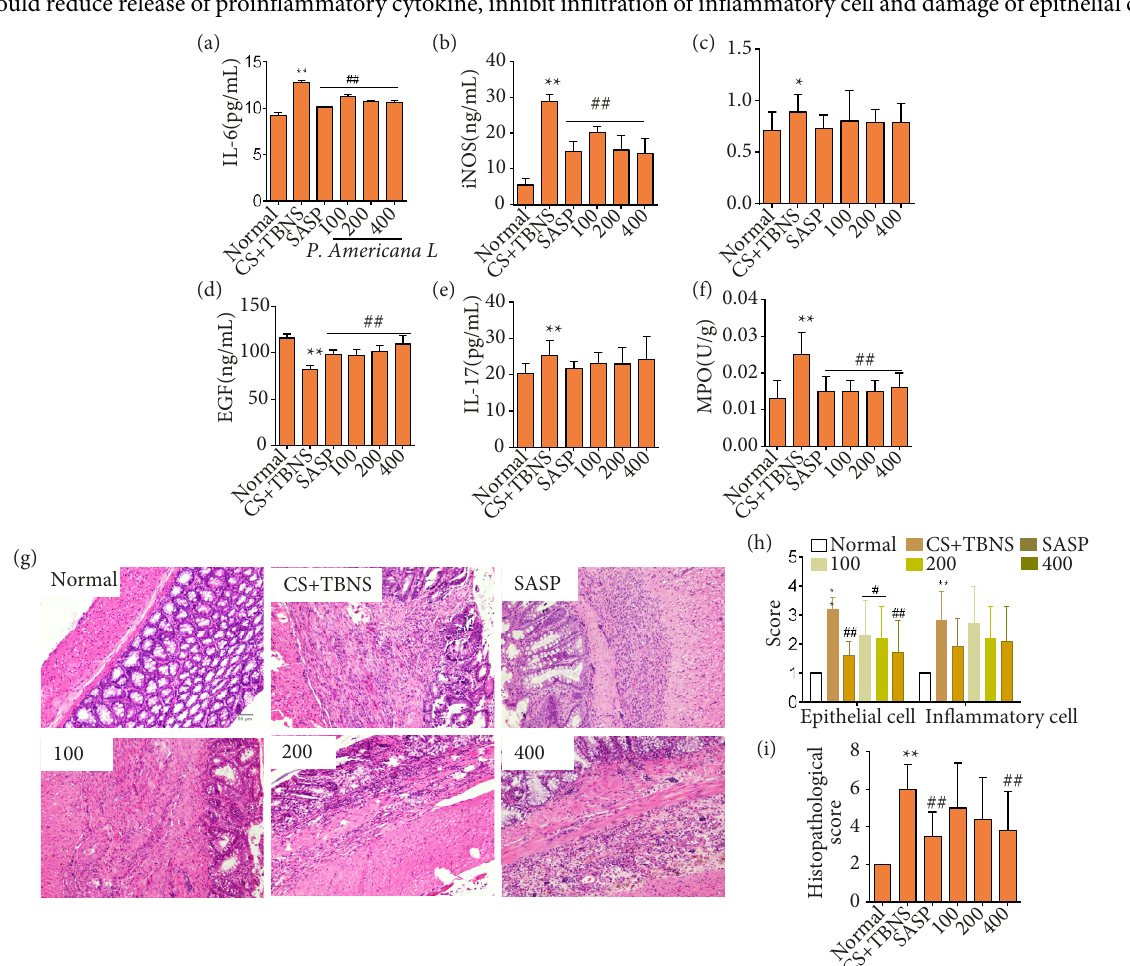
Figure 4 - Periplaneta americana L. reduces release of proinflammatory cytokine, inhibits infiltration of inflammatory cell and damage of epithelial cell. These cytokines, such as (a) IL-6, (b) iNOS, (c) COX-2, (d) EGF, (e) IL-17, and (f) MPO were detected by ELISA. (g) The photomicrographs of hematoxylin & eosin staining on colonic sections of rats. (h) Epithelial cell scores and inflammatory cell infiltration were determined. (i) Histopathological scores of each group were determined. Scale bars: 50 μ m; magnification: 200×. Data were presented as mean ± standard deviation (n = 6 per